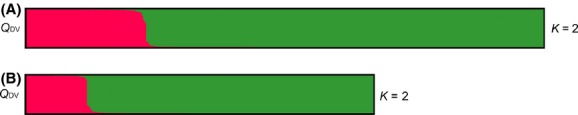
Overall genetic classification of 718 sympatric Alaskan Arctic char (S. alpinus) and Dolly Varden (S. malma) using 12 microsatellite loci from (A) Lake Aleknagik and (B) Lake Nerka. Assignment in STRUCTURE was based on the probability of belonging to two a priori genetic groups (K = 2). Individuals are arranged according to decreasing QDV -values (i.e., the proportion of red in each line) and both sampling years, 2012 and 2013, are shown. Colour codes are as follows: red = S. malma, green = S. alpinus.